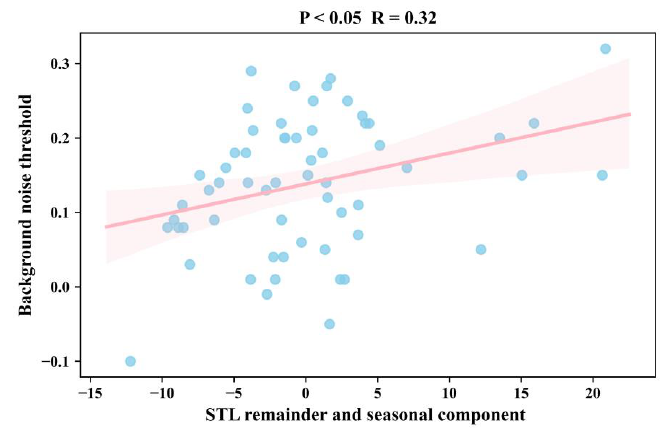
Figure 10. The correlation between background noise and seasonal-trend decomposition procedure based on loess (STL) remainder and seasonal component. STL remainder and seasonal component is the sum of all regional